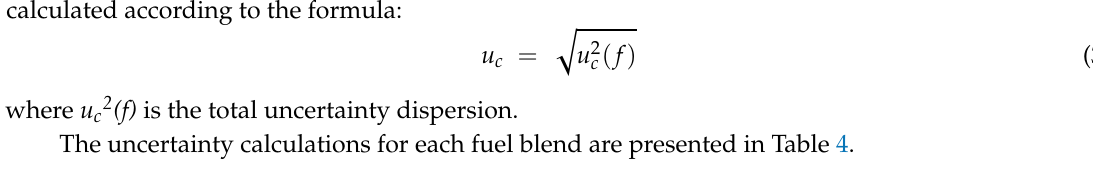
Table 4. Comparison of fuel properties of di ff erent fuel blends used and uncertainty ranges u c of each fuel blend